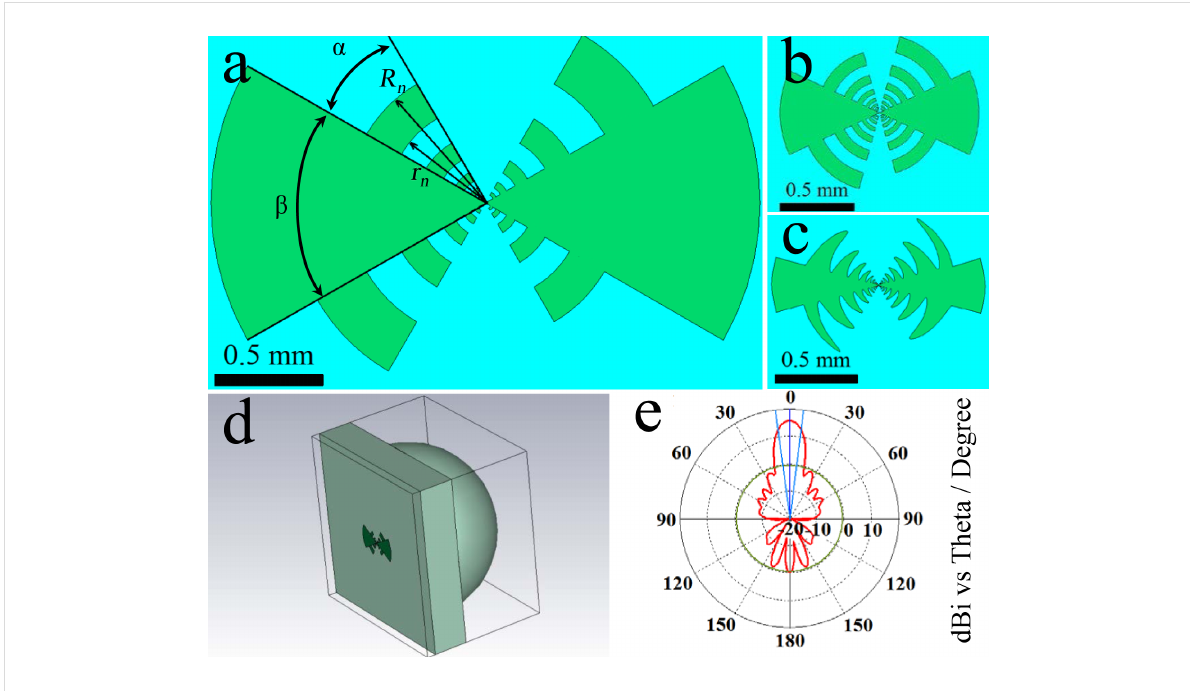
Figure 1: (a–c) Three log-periodic antennas of various geometries; (d) system with a lens (d) and (e) beam pattern at 250